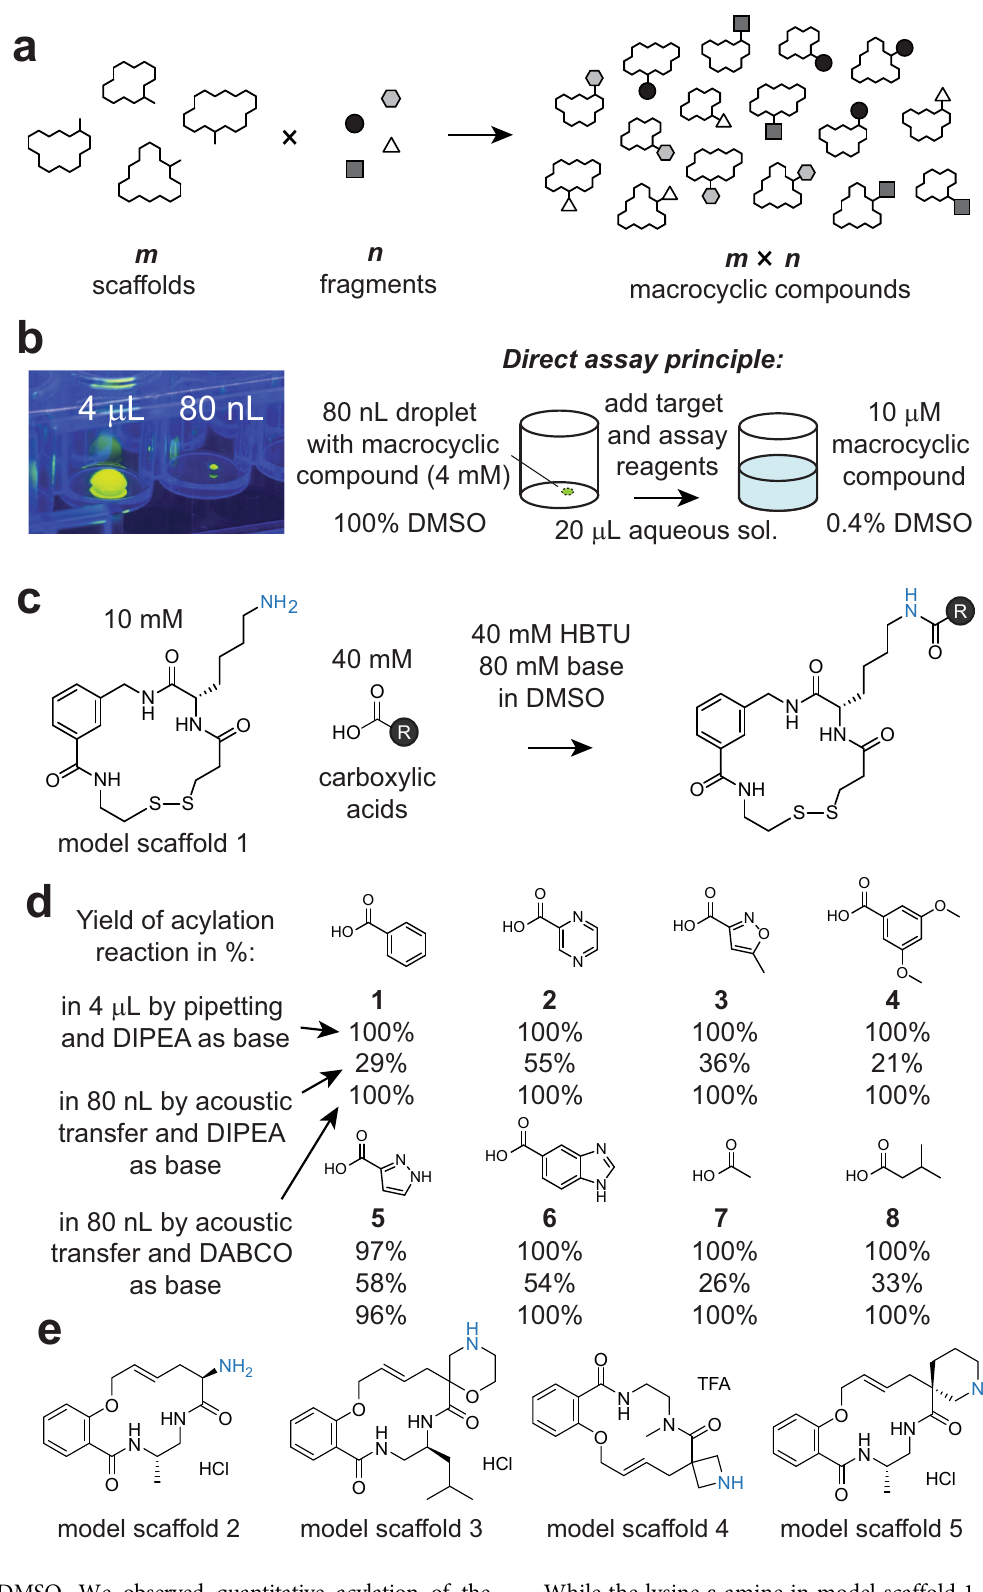
solubility in DMSO. We observed quantitative acylation of the macrocycles by test acids ( 1 , 4 , 7 ) using the new bases, despite the nanoliter droplet transfers (Supplementary Fig. 2). We chose DABCO for reactions with acids 1 – 8 and demonstrated quantitative modi fi cation of a peripheral primary amine at the nanomole scale (lowest number in Fig. 1d; Supplementary Fig. 3). NATURE COMMUNICATIONS| (2022) 13:3823